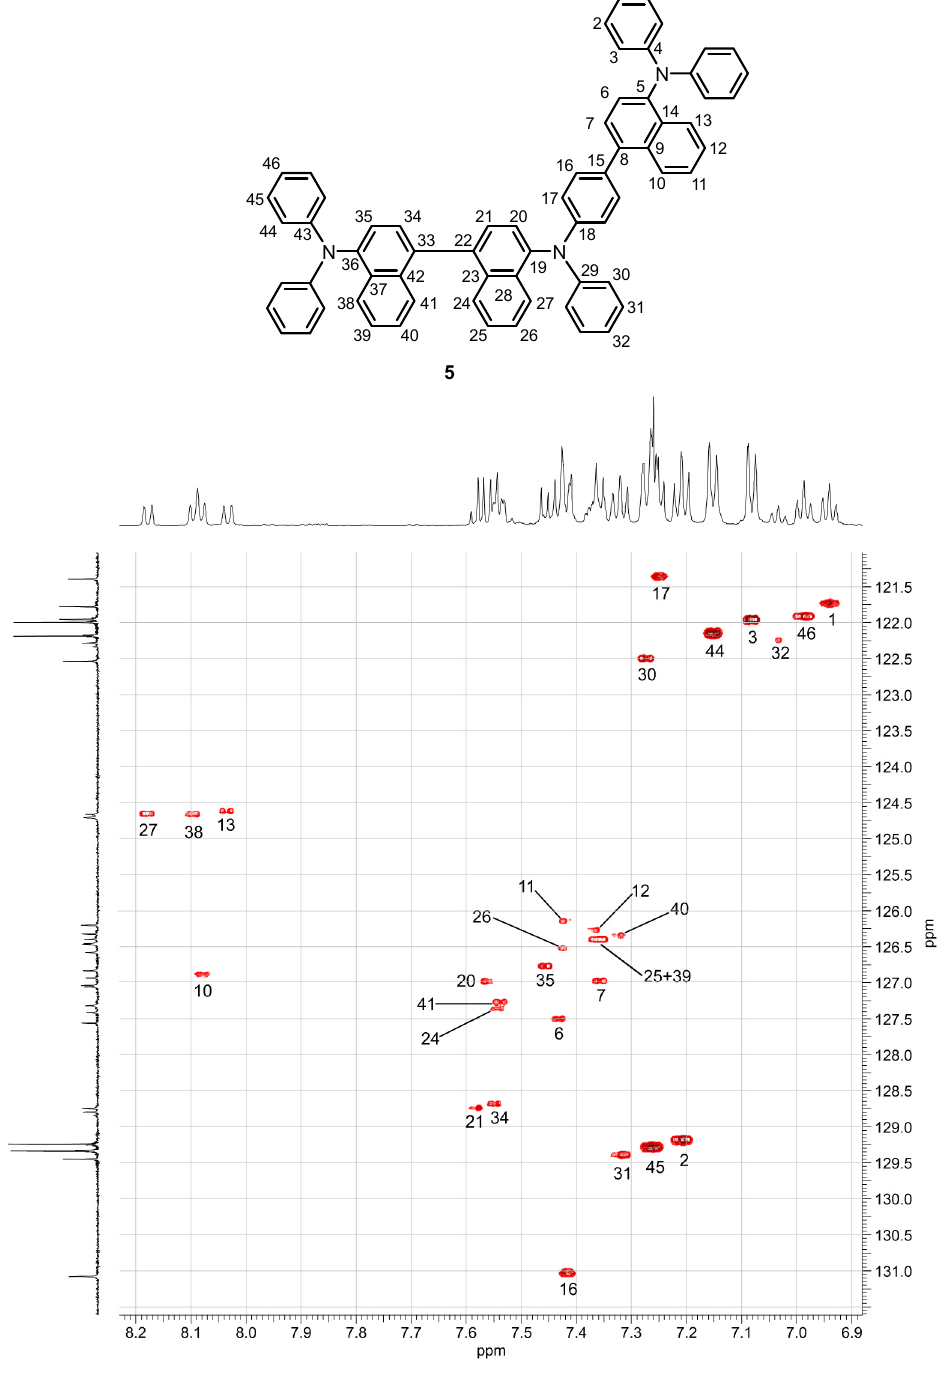
Figure 6. Assignment of the 13 C-NMR signals of the N , N , N ’, N ’-tetraarylnaphthidine ( 5 ) to the respective 1 H-NMR signals by the HSQC spectrum.